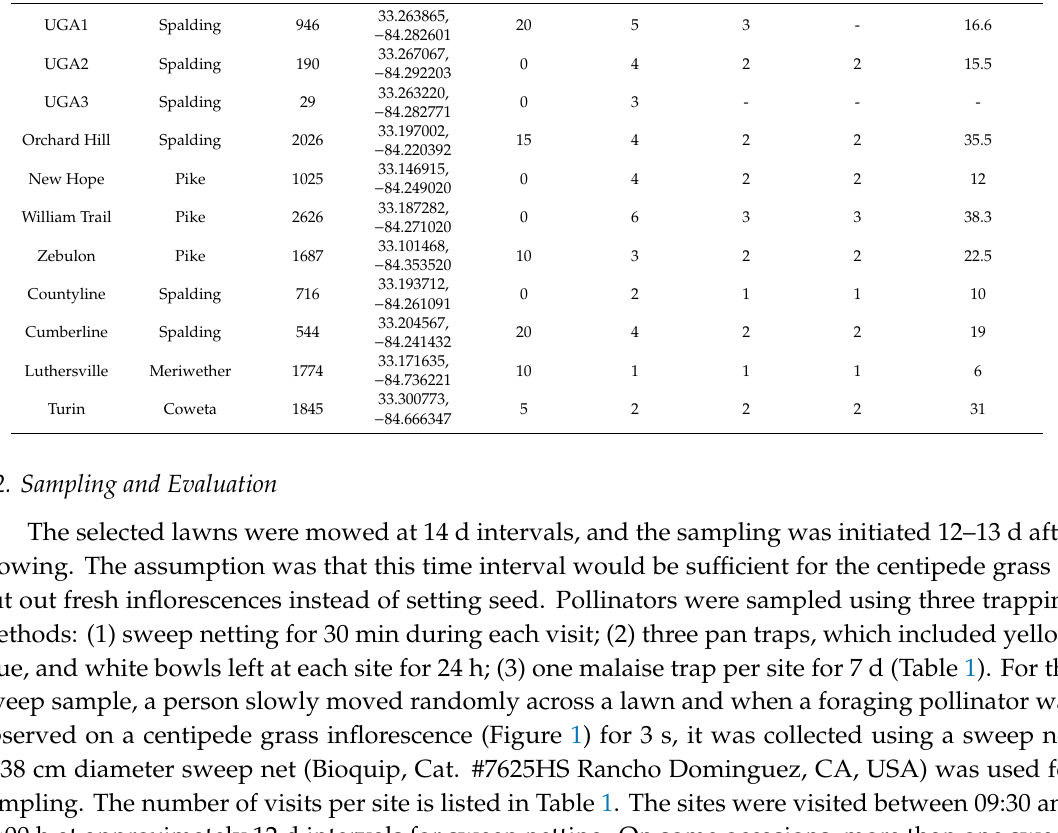
Table 1. Details on the study sites and the number of times traps were deployed in each site. Lawn